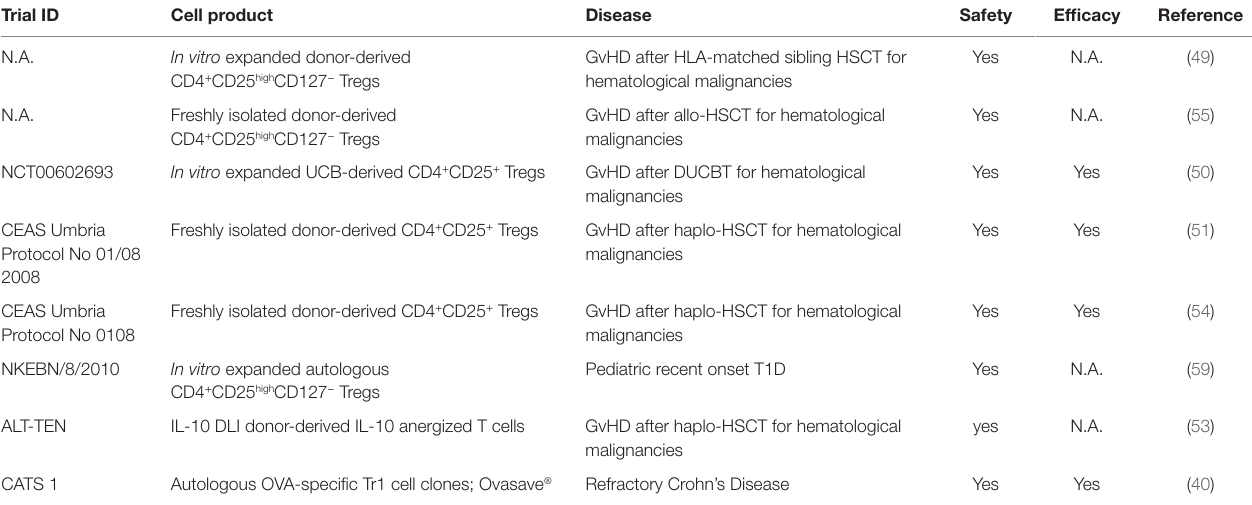
tABLe 1 | completed treg-based clinical